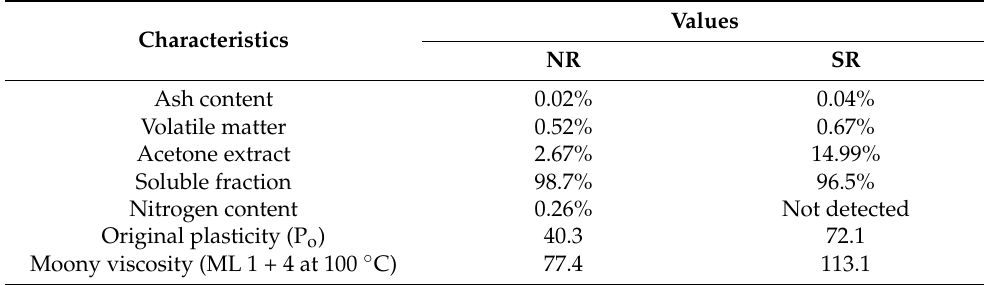
Table 1. Characteristics of NR and SR.